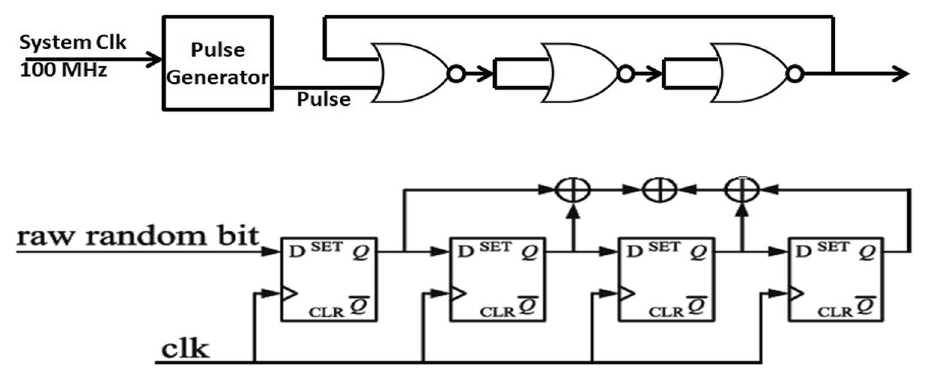
Fig. 9 A 4 stage XOR